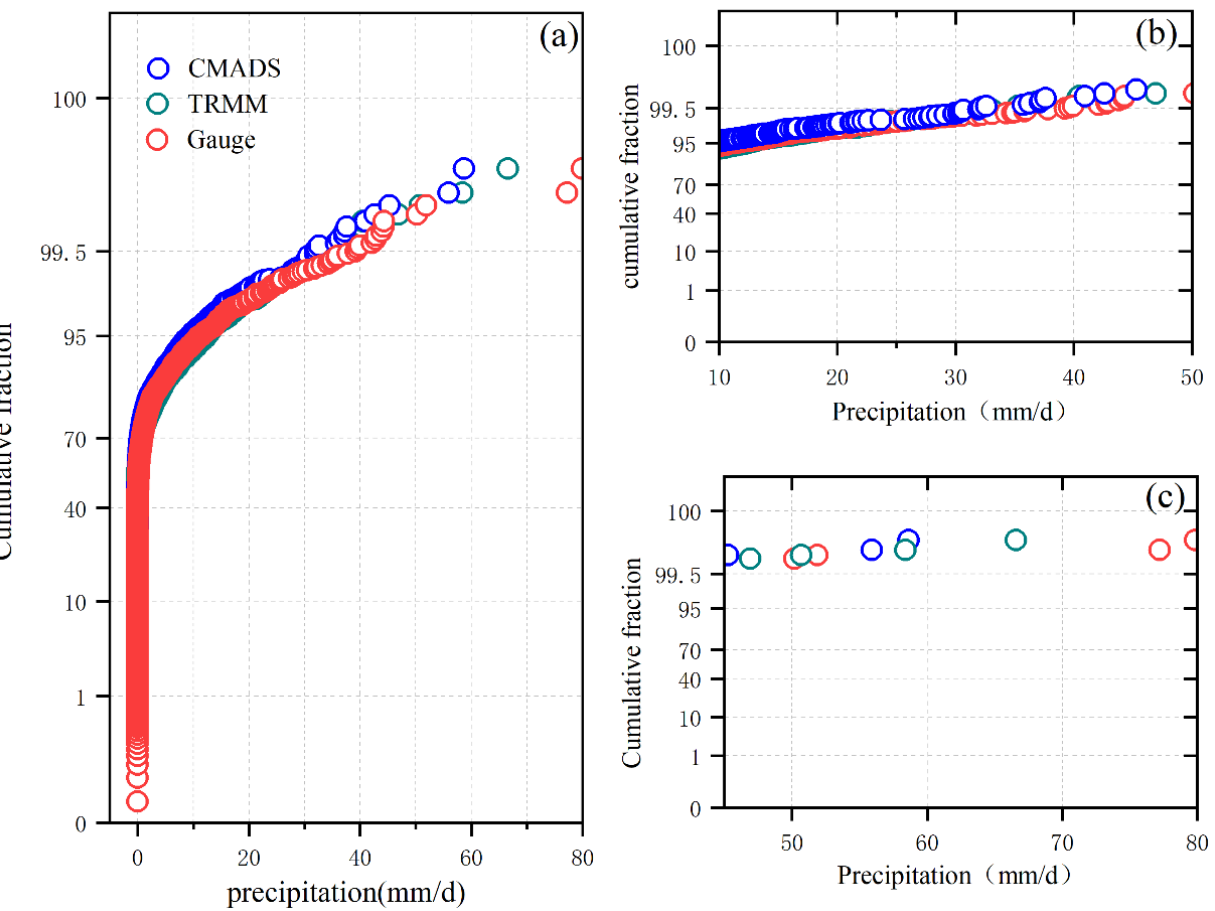
Figure 5. Cumulative frequencies of daily precipitation intensity for Gauge (red points), CMADS (blue points), and TRMM (green points) in the DRB: ( a ) distribution of all precipitation values, ( b ) distribution of precipitation values that are <50 mm, and ( c ) distribution of precipitation values that are ≥ 50 mm.